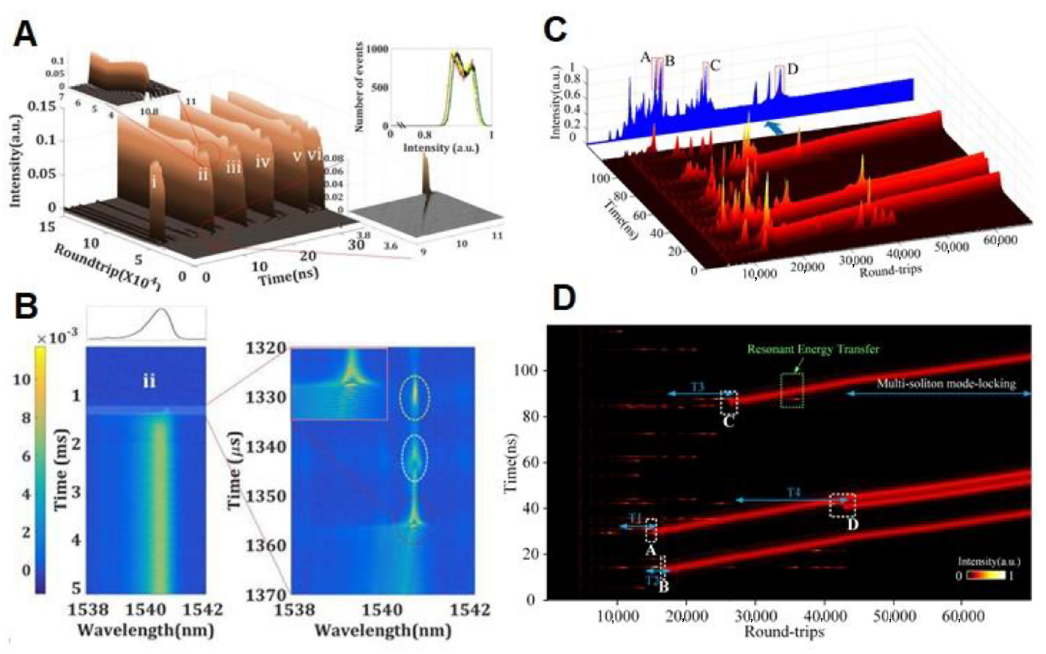
Figure 15: Multi-soliton buildup dynamics with different ways. (A, B) Synchronous generation. Yu et al. [260]. © American Institute of Physics 2017; (C, D) Asynchronous